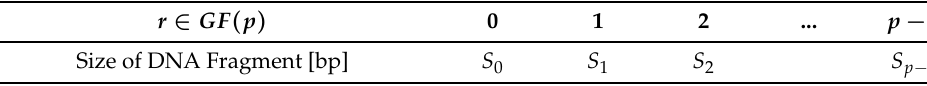
Table 1. DNA representation for elements in GF ( p ) . r ∈ GF ( p